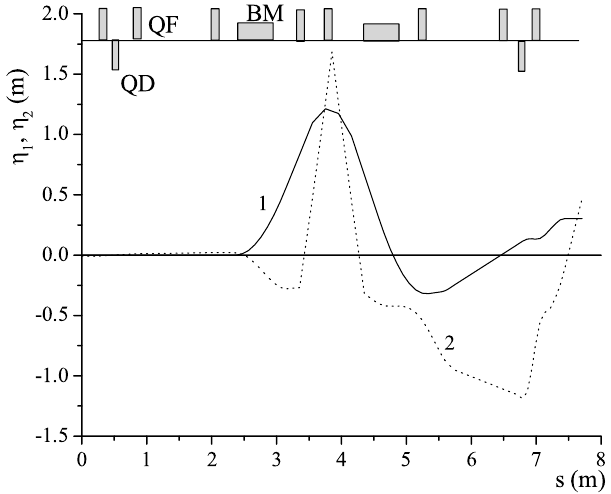
(cid:3) 1 (cid:4) and second one 1